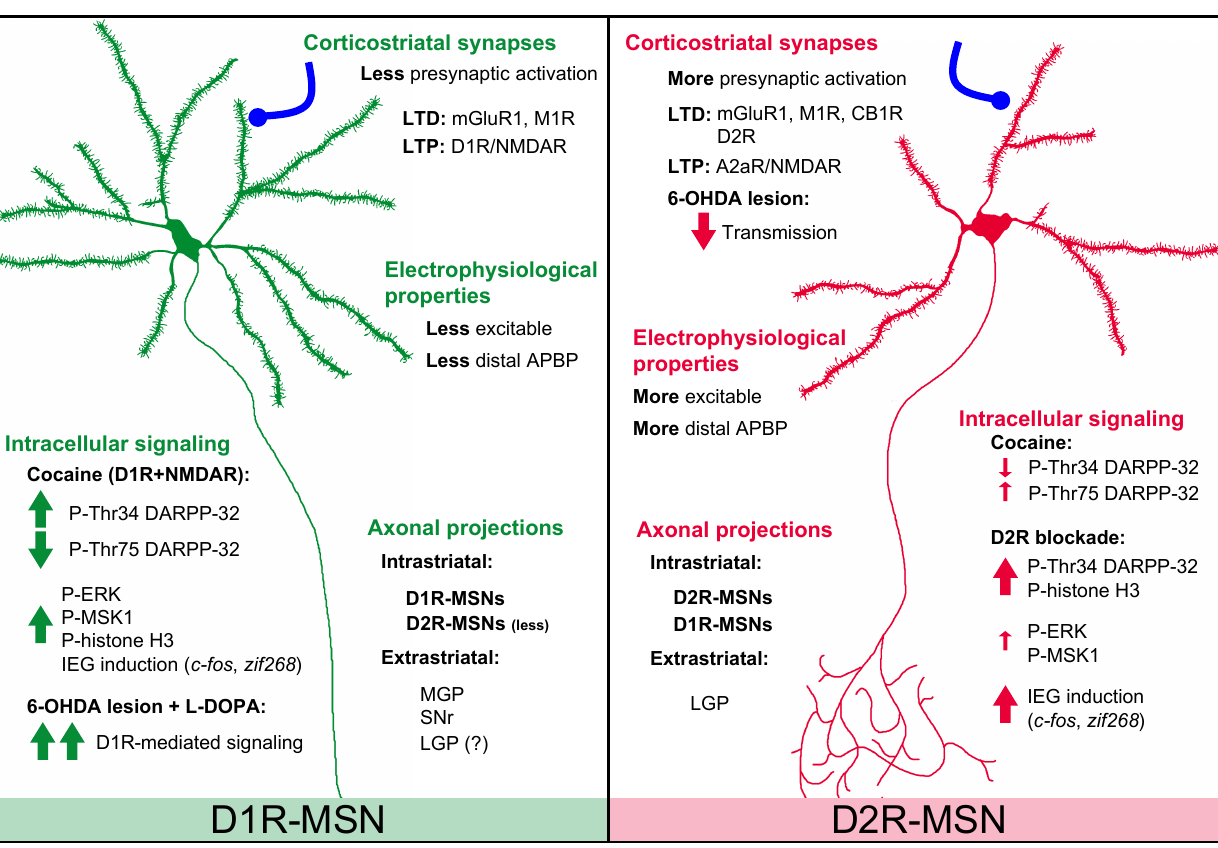
Figure 1 | Summary of major differences between D1r-MSNs and D2r-MSNs based on data from BAC transgenic mice. Electrophysiological properties: D1R-MSNs appear less excitable than D2R-MSNs probably due to the different number of primary dendrites and/or differences in presynaptic input (Kreitzer and Malenka, 2007; Cepeda et al., 2008; Gertler et al., 2008). D2R-MSNs show stronger GABAA receptor-mediated synaptic responses and tonic currents than D1R-MSNs (Ade et al., 2008; Taverna et al., 2008; Janssen et al., 2009). Single back-propagating action potentials invade more distal dendritic regions in D2R- than in D1R-MSNs, a difference involving voltage- dependent Na + channels and Kv4 K + channels (Day et al., 2008). Corticostriatal synapses: High-frequency stimulation-induced CB1R-mediated LTD is exclusively observed in D2R-MSNs and requires stimulation of D2Rs (Kreitzer and